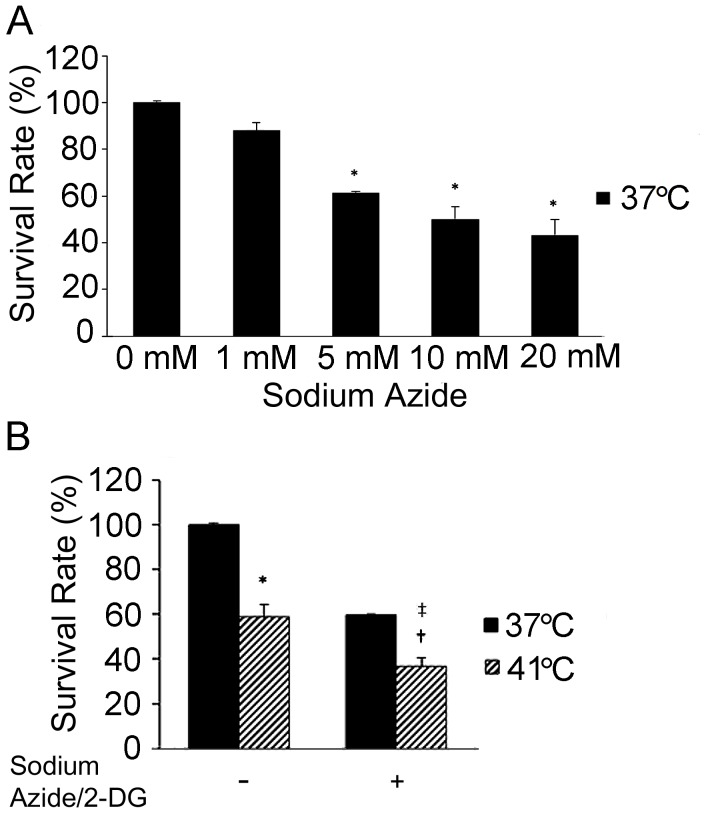
Temperature increase exacerbated sodium azide/2-DG-induced cell death.(A) Sodium azide caused dose-dependent cell death. Neuronal death was induced with different concentrations of sodium azide plus 0.5 mM 2-DG for a period of 1 hour. The time point of cell collection for the analysis was decided based on the findings from our preliminary studies. Cell survival was detected with trypan blue exclusion assay. Error bars represent mean ± SEM. n = 4. * denotes significant difference from 37°C control cell (0 mM) (p<0.01). (B) Increased temperature resulted in more cell death. Cells were treated as indicated for a period of 1 hour and cell survival was detected with trypan blue exclusion assay. * denotes significant difference from 37°C control (p<0.01). † denotes significant difference from 37°C with sodium azide/2-DG (p<0.01). ‡ denotes significant difference from 41°C without sodium azide/2-DG (p<0.05).